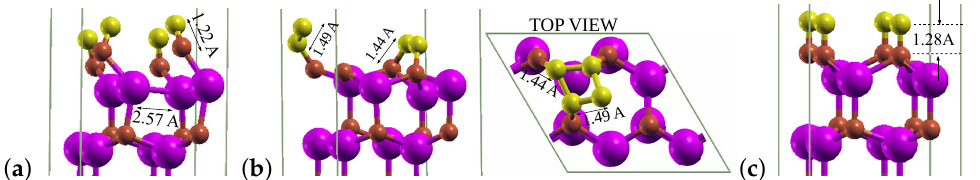
Figure 7. Final sites of C atoms on GaN ( 000¯1 ) . Coverage: 1 ML; adsorption is initiated from sites: ( a ) T4 and H3. ( b ) Bridge. ( c ) On top.